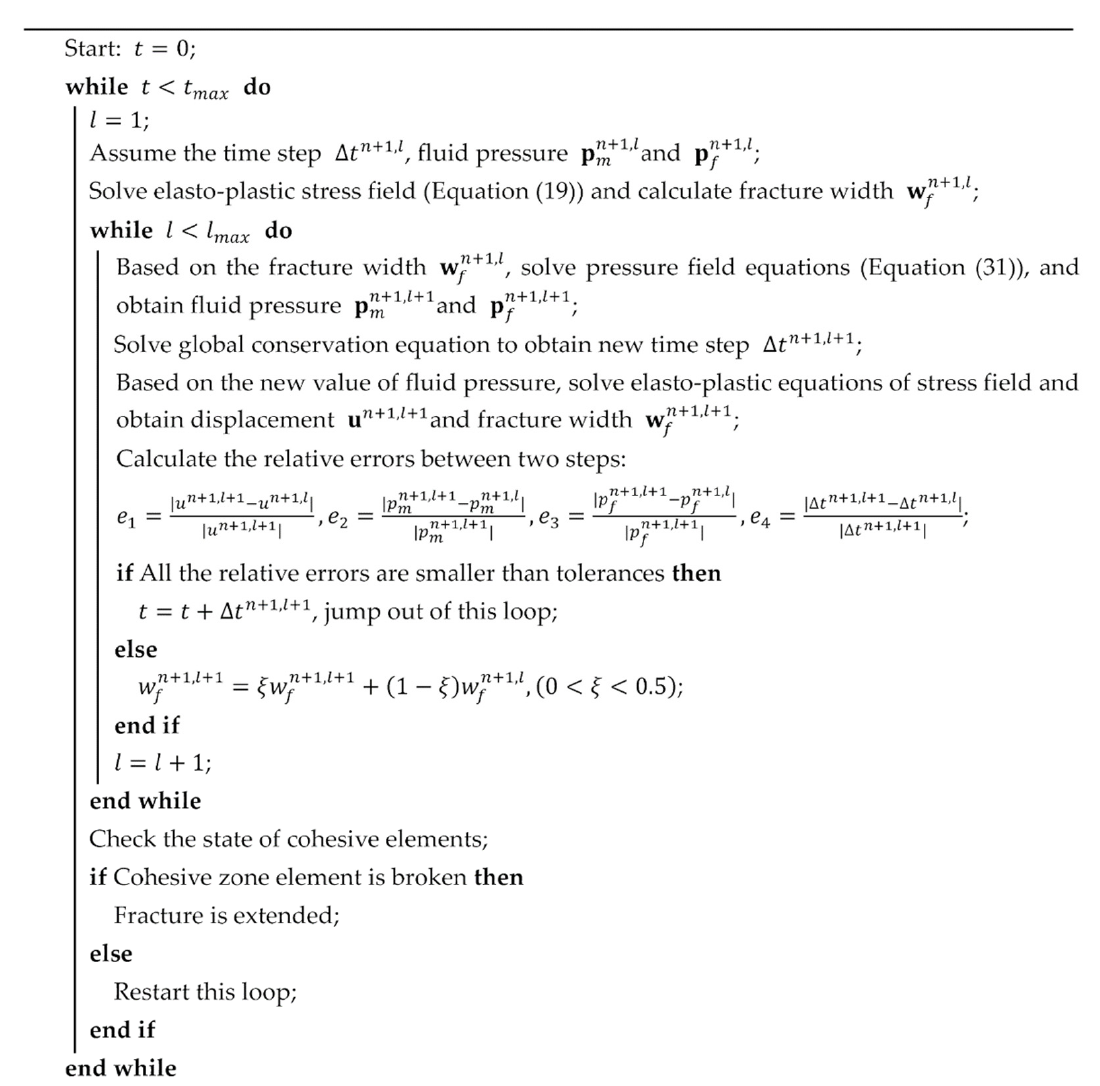
Figure 3. Overall iterative procedure for hydraulic fracture propagation.